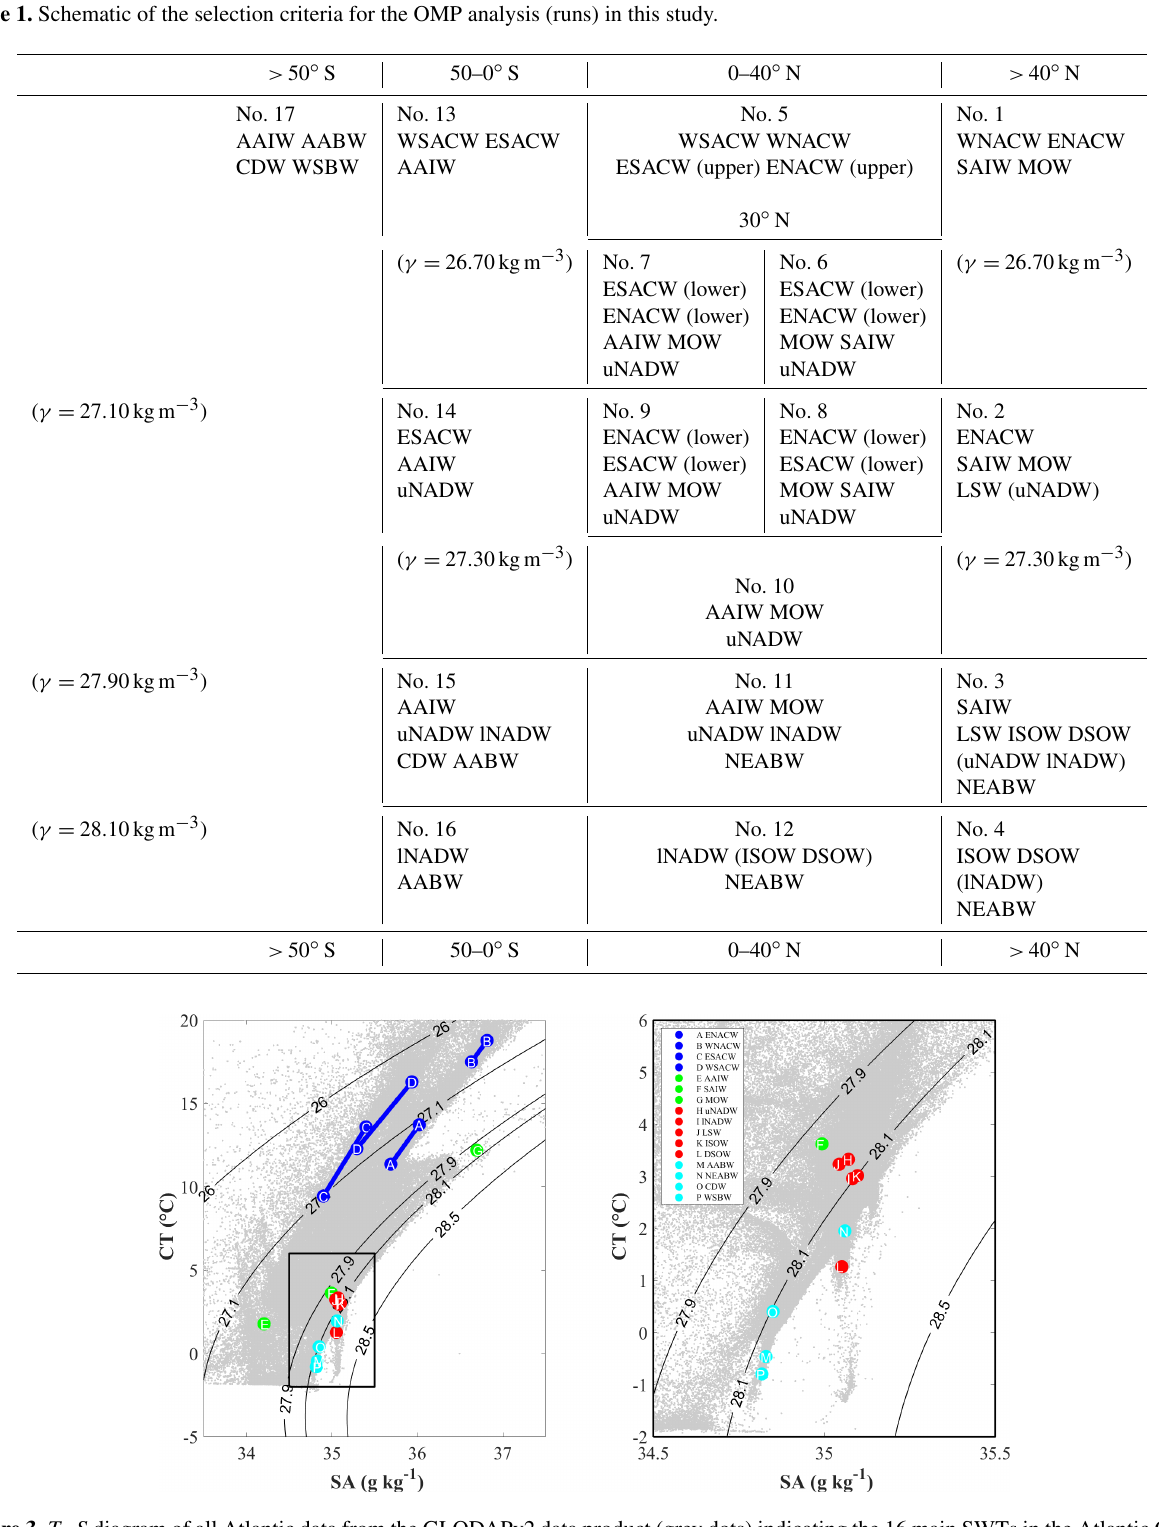
Figure 3. T – S diagram of all Atlantic data from the GLODAPv2 data product (grey dots) indicating the 16 main SWTs in the Atlantic Ocean discussed in this study. The coloured dots with letters A–D show the upper and lower boundaries of central waters, and E–P show the mean values of other